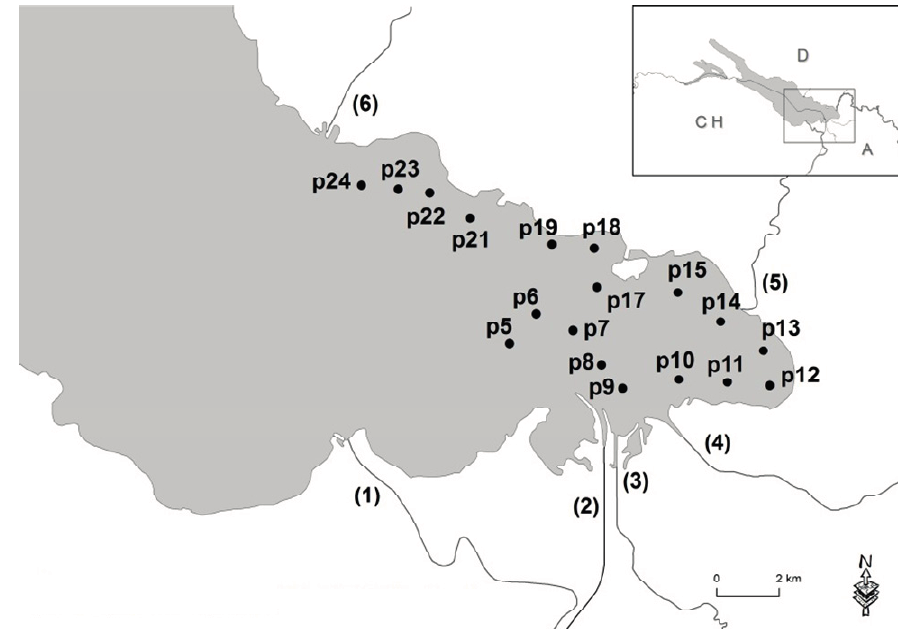
Figure 1. Eastern Lake Constance. The sampling points on 25 May 2012, are indicated, as p5p24. The main inflows are: ( 1 ) Old Rhine, ( 2 ) Alpine Rhine, ( 3 ) Dornbirner Ach, ( 4 ) Bregenzer Ach, ( 5 ) Leiblach and ( 6 ) Argen. Reproduced with permission of the Federal Office of Topography